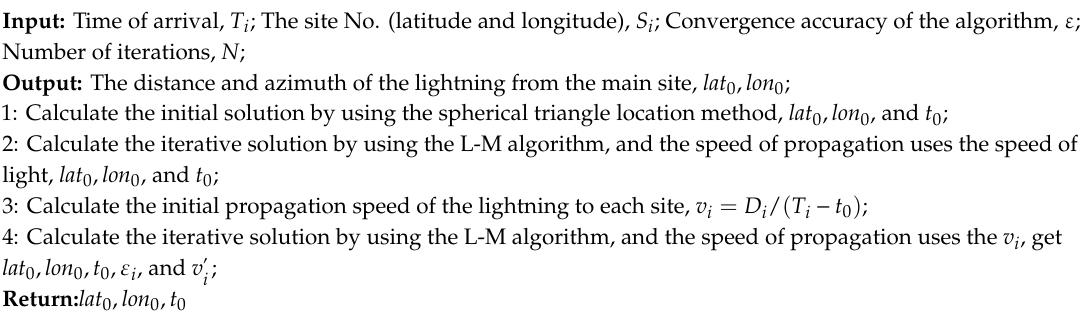
Algorithm 1 Improved Levenberg-Marquardt iterative